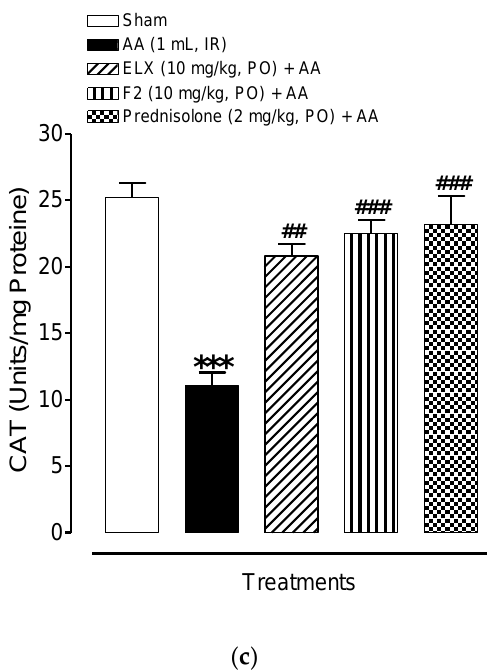
Figure 9. Pre-treatment with ELX and F2 improved ( a ) MDA, ( b ) GSH, and ( c ) CAT in Wistar albino rats induced with AA colitis. Data are represented in means ± SEM ( n = 6). One-way ANOVA was used for statistical analysis followed by Tukey’s post-test. *** p < 0.001 compared with sham group; ## p < 0.01, ### p < 0.001 compared with AA alone. ELX = Eluxadoline, F2 = formulation, AA = acetic acid, PO = orally, IR = intrarectally, MDA = malondialdehyde, GSH = total glutathione, CAT = catalase.